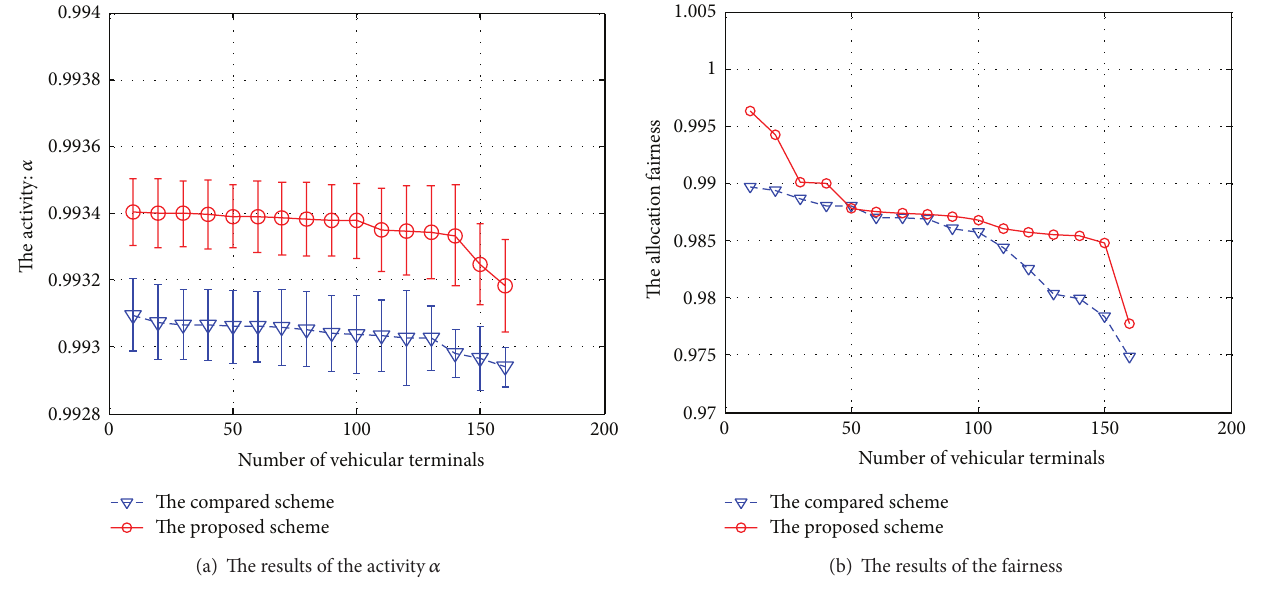
Figure 7: The simulation results under different vehicular